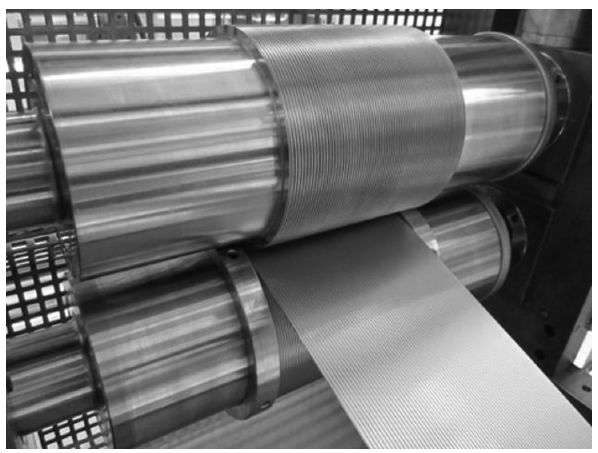
Figure 10 Downstream side of mating roll 150 mm with microstruc- tured